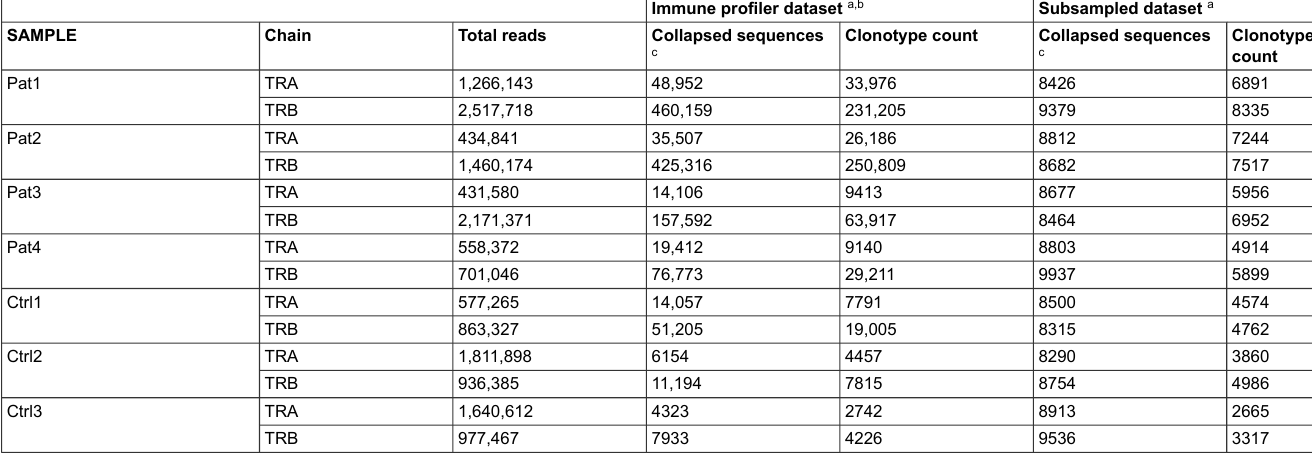
Table 2: T cell receptor sequencing dataset run through standard Cogent NGS Immune Profiler pipeline compared with our in-house subsampling